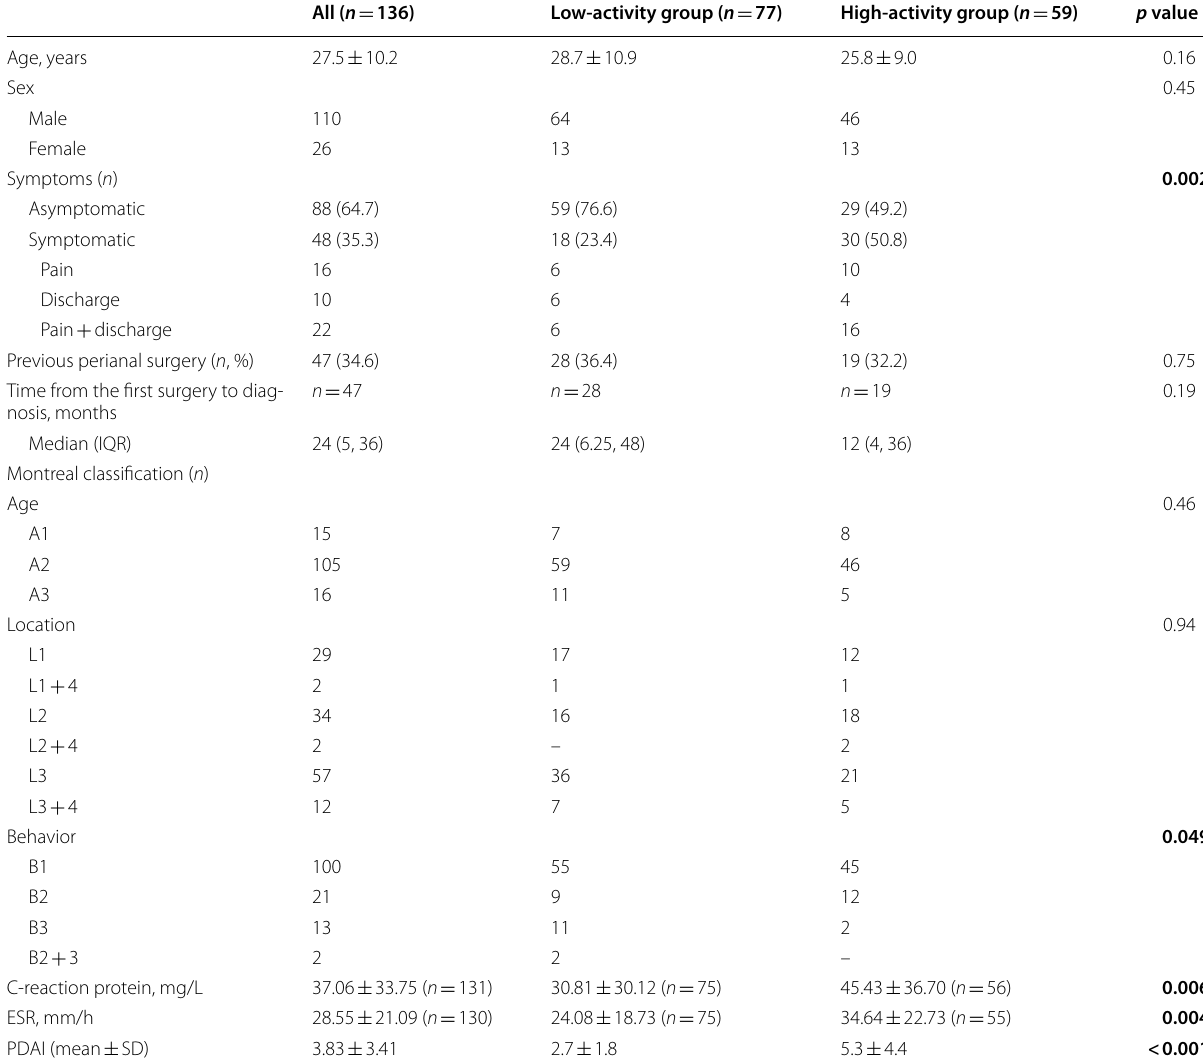
Table 1 Demographic data of all